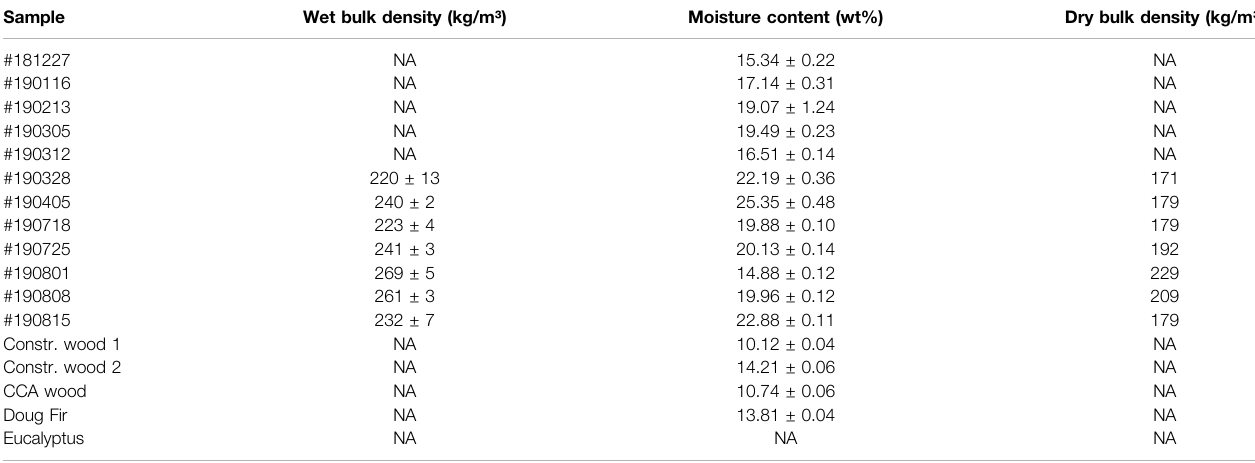
TABLE 1 | Physical properties of CCDWDF materials ( < 6 mm) and reference woods. Sample